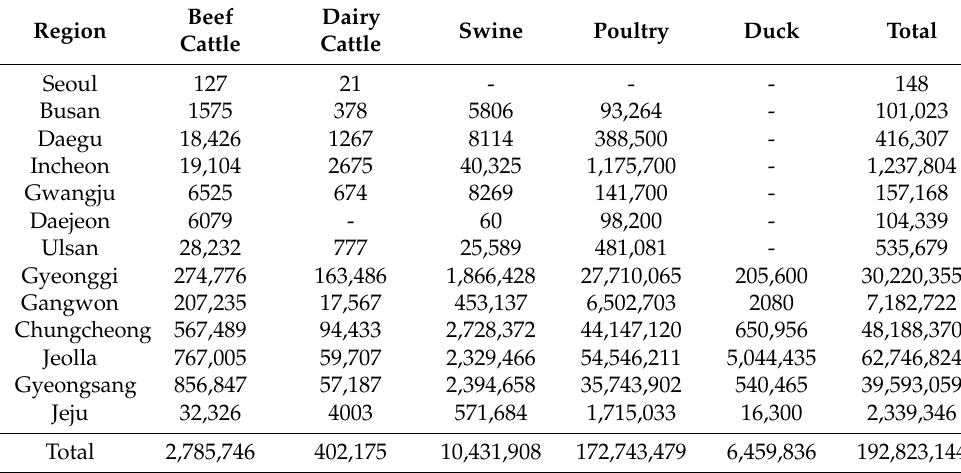
Figure 3. Livestock ratio by region (2017) .